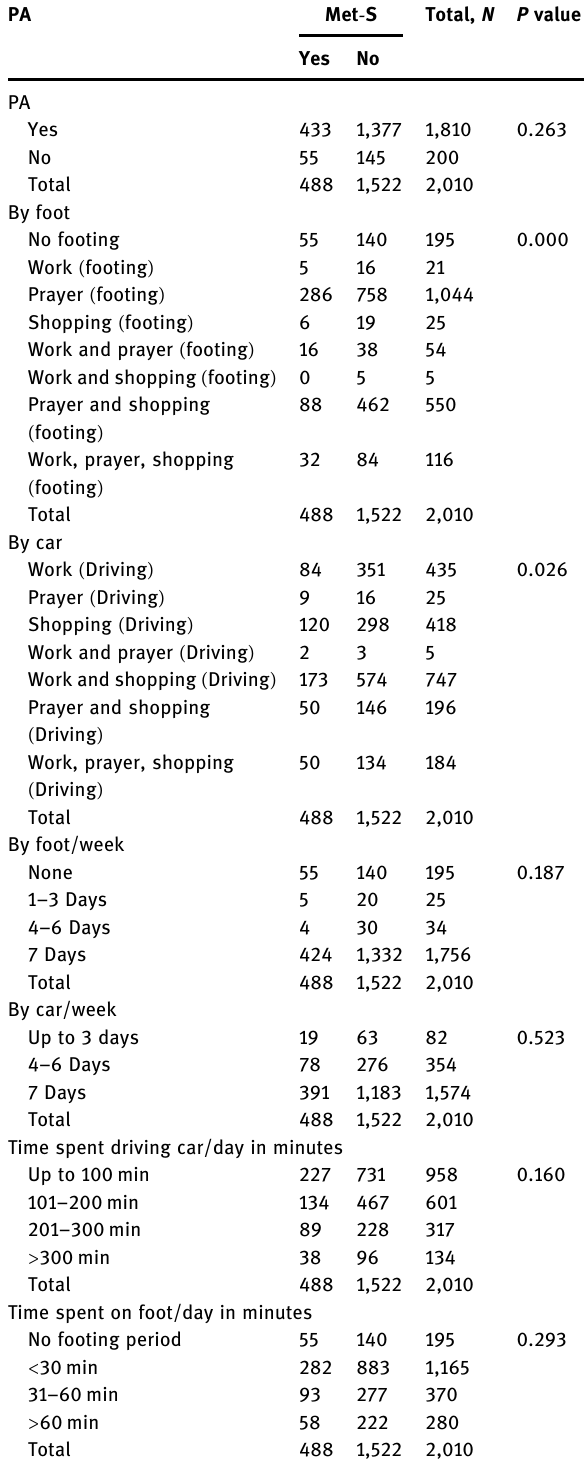
Table 4: Association between Met - S and